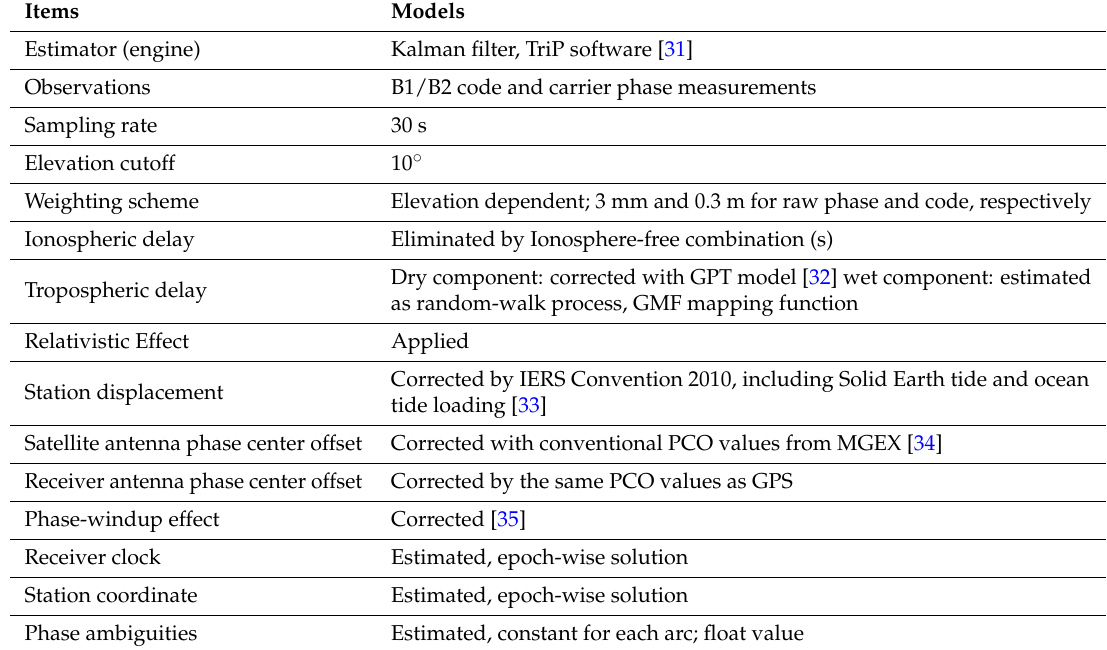
Table 3. PPP processing